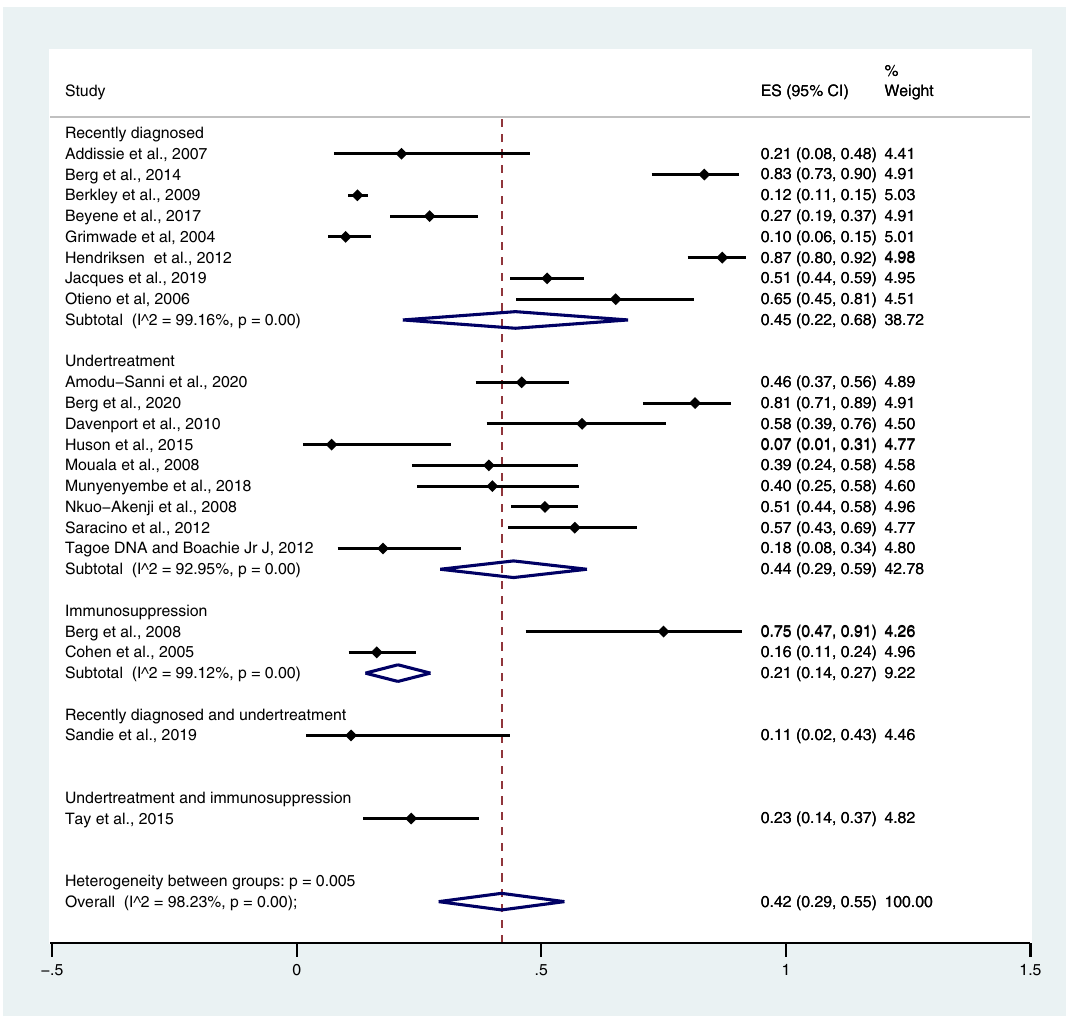
Figure 2. The pooled prevalence estimate of severe malaria in Plasmodium spp. and HIV co-infected